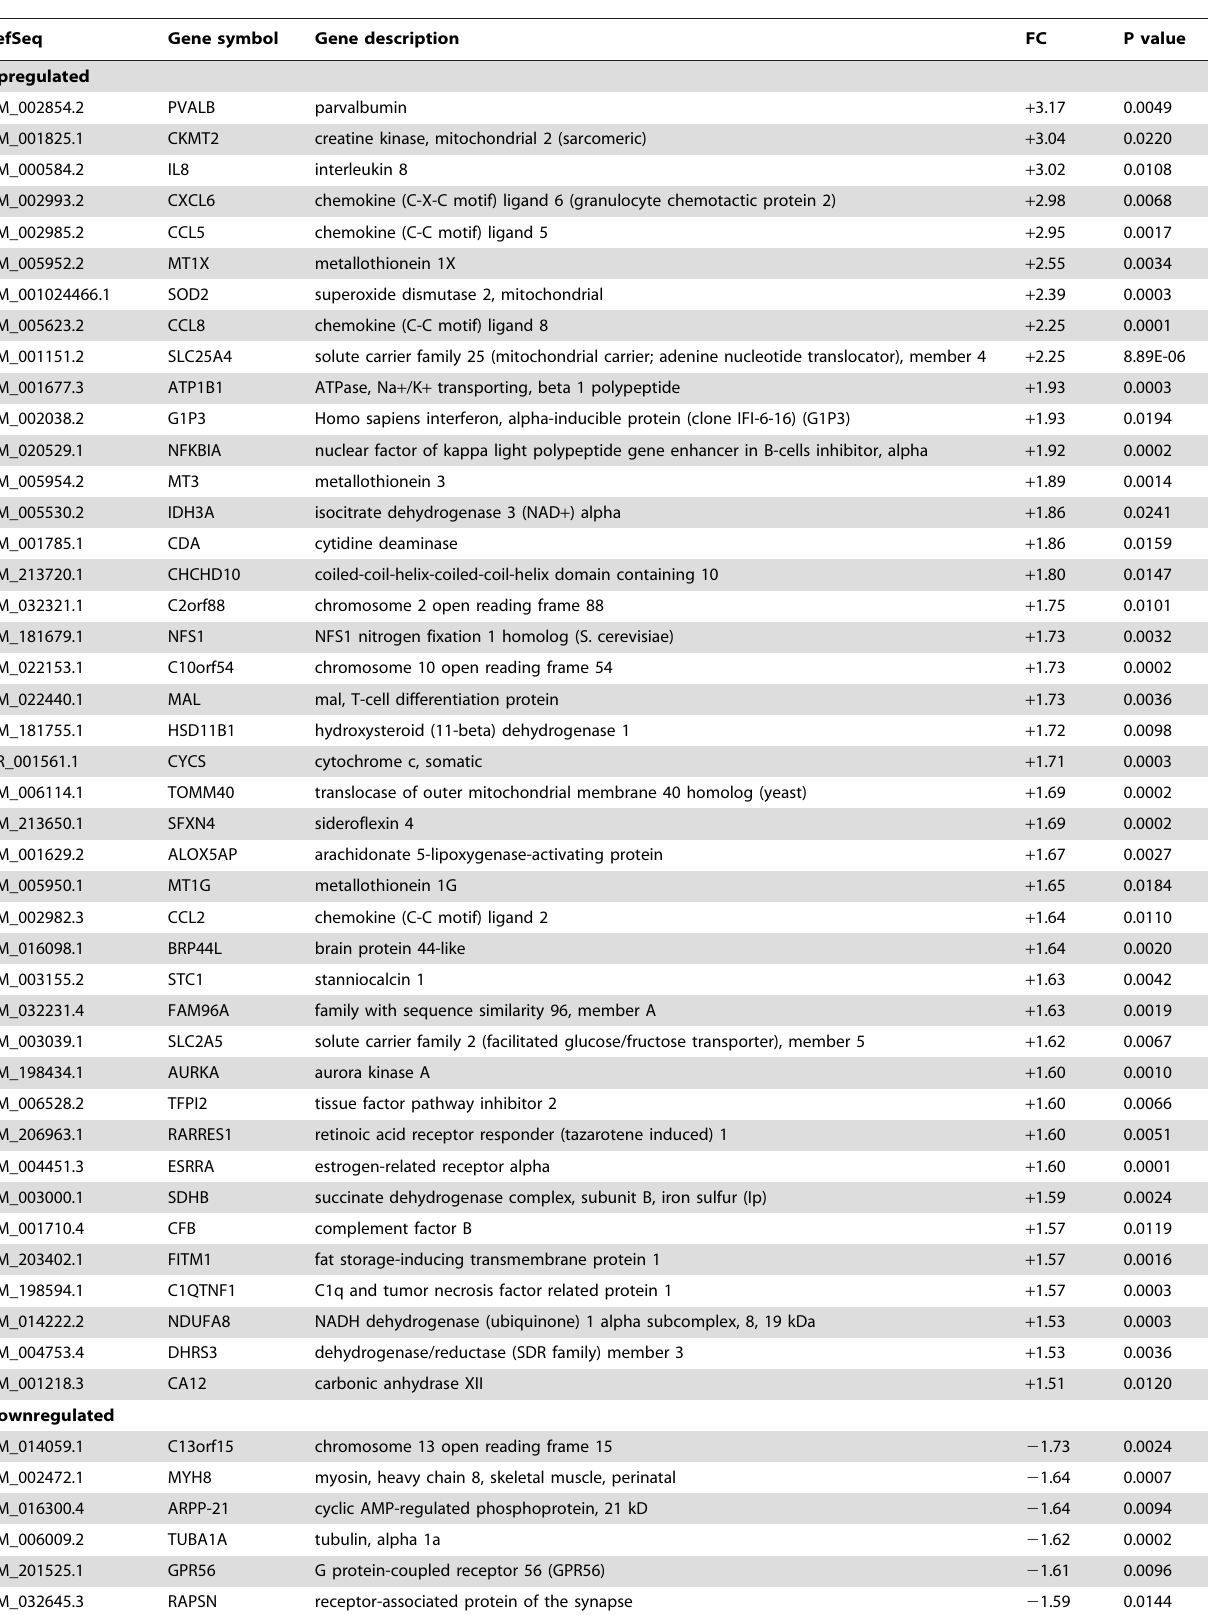
Table 1. Differentially expressed genes in response to PGC-1 a -overexpression in cultured muscle cells.